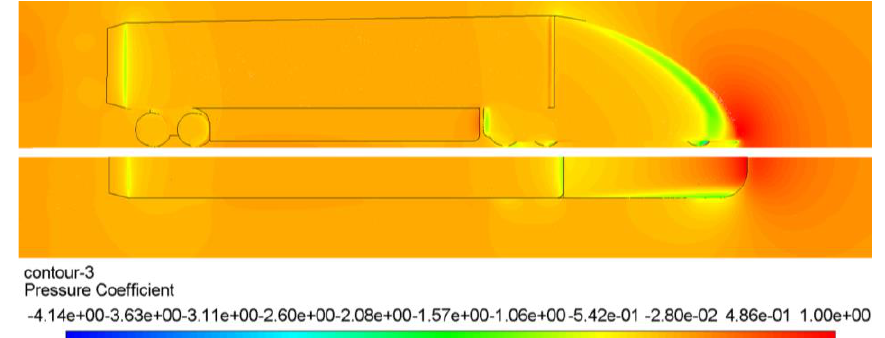
Fig. 25. Side view (top) and plan view (bottom) of the airflow pressure coefficient over Concept Two – Revision